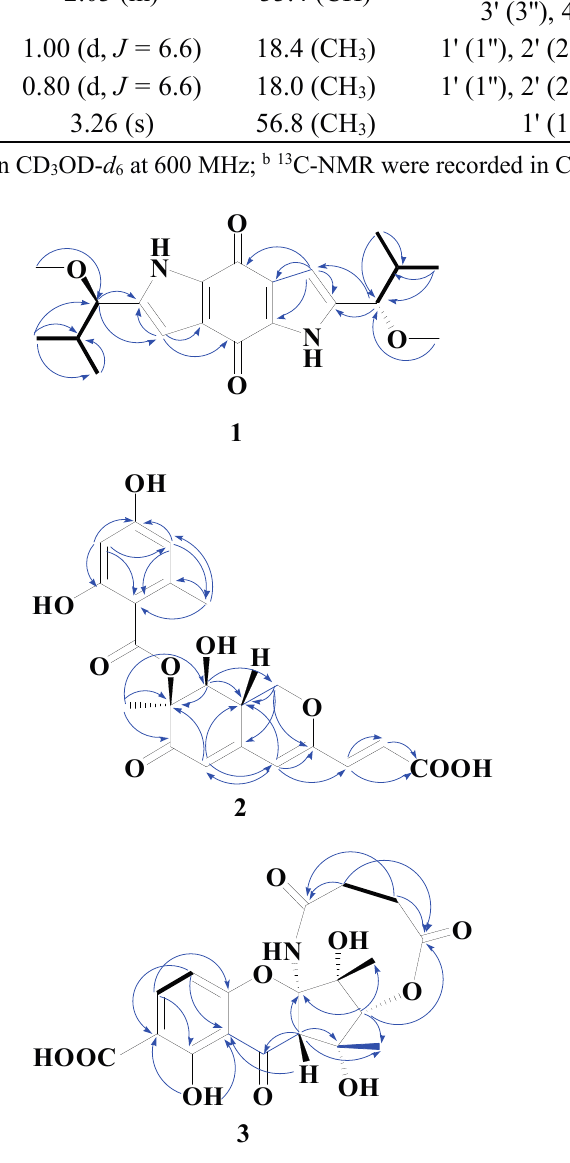
Figure 2. 1 H- 1 H COSY correlations (bold lines) and selected HMBC ( 1 H → 13 C) (single lines) correlations of 1 – 3